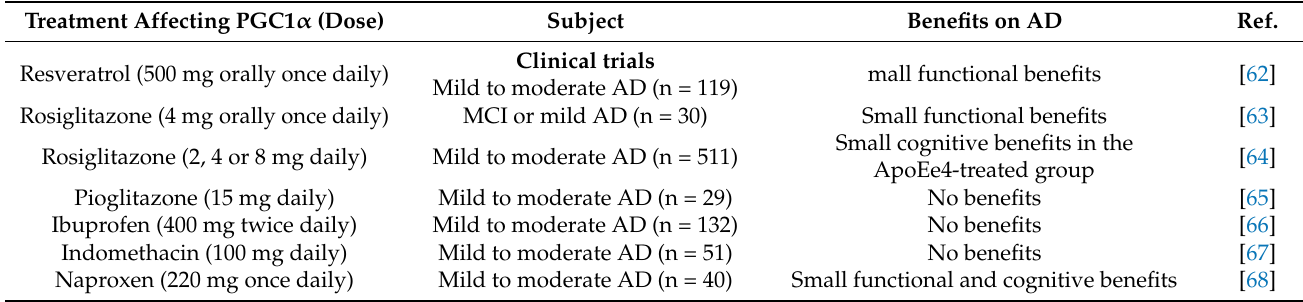
Table 2. Clinical trials with treatments targeting PGC1 α in Alzheimer’s